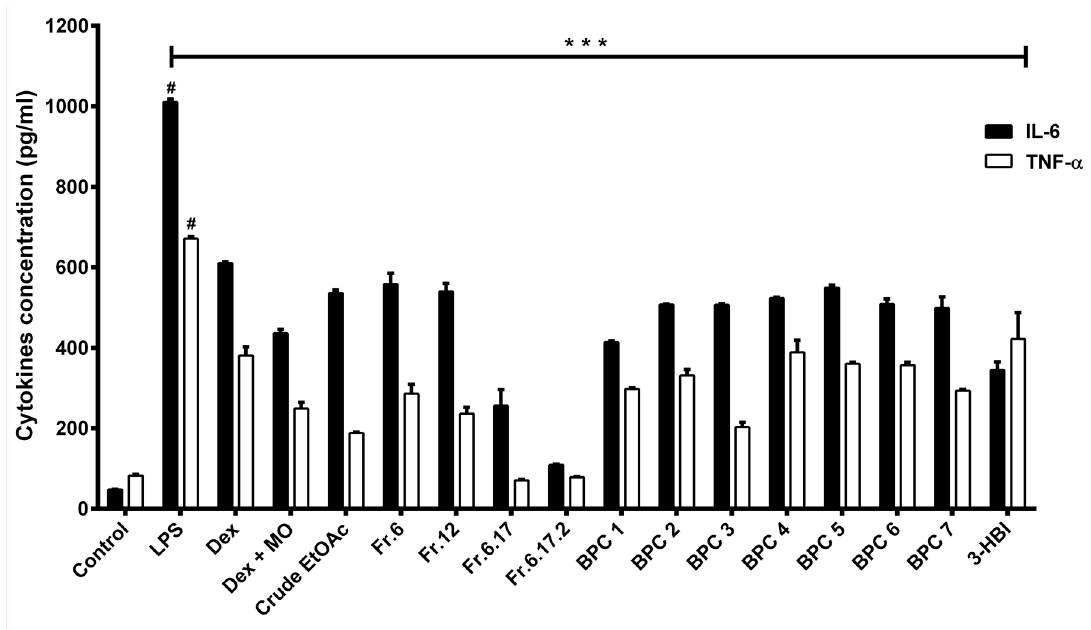
Figure 5. E ff ect of MO leaves extract on pro-inflammatory cytokines levels in LPS-induced MDM. Data are presented as means ± SEM. # p < 0.001 compared to control, *** p < 0.001, compared to LPS. Control: Untreated MDM; LPS: Lipopolysaccharide-stimulated MDM; Dex: Dexamethasone; Dex +